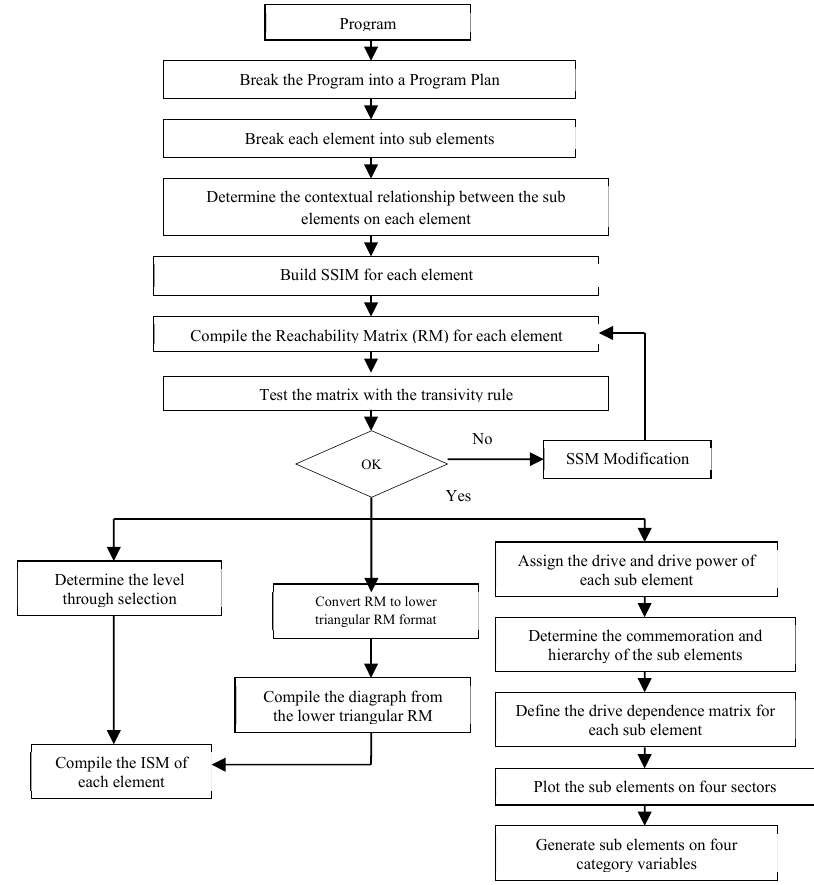
Fig. 2. Analytical Framework uses the ISM approach Source: Marimin